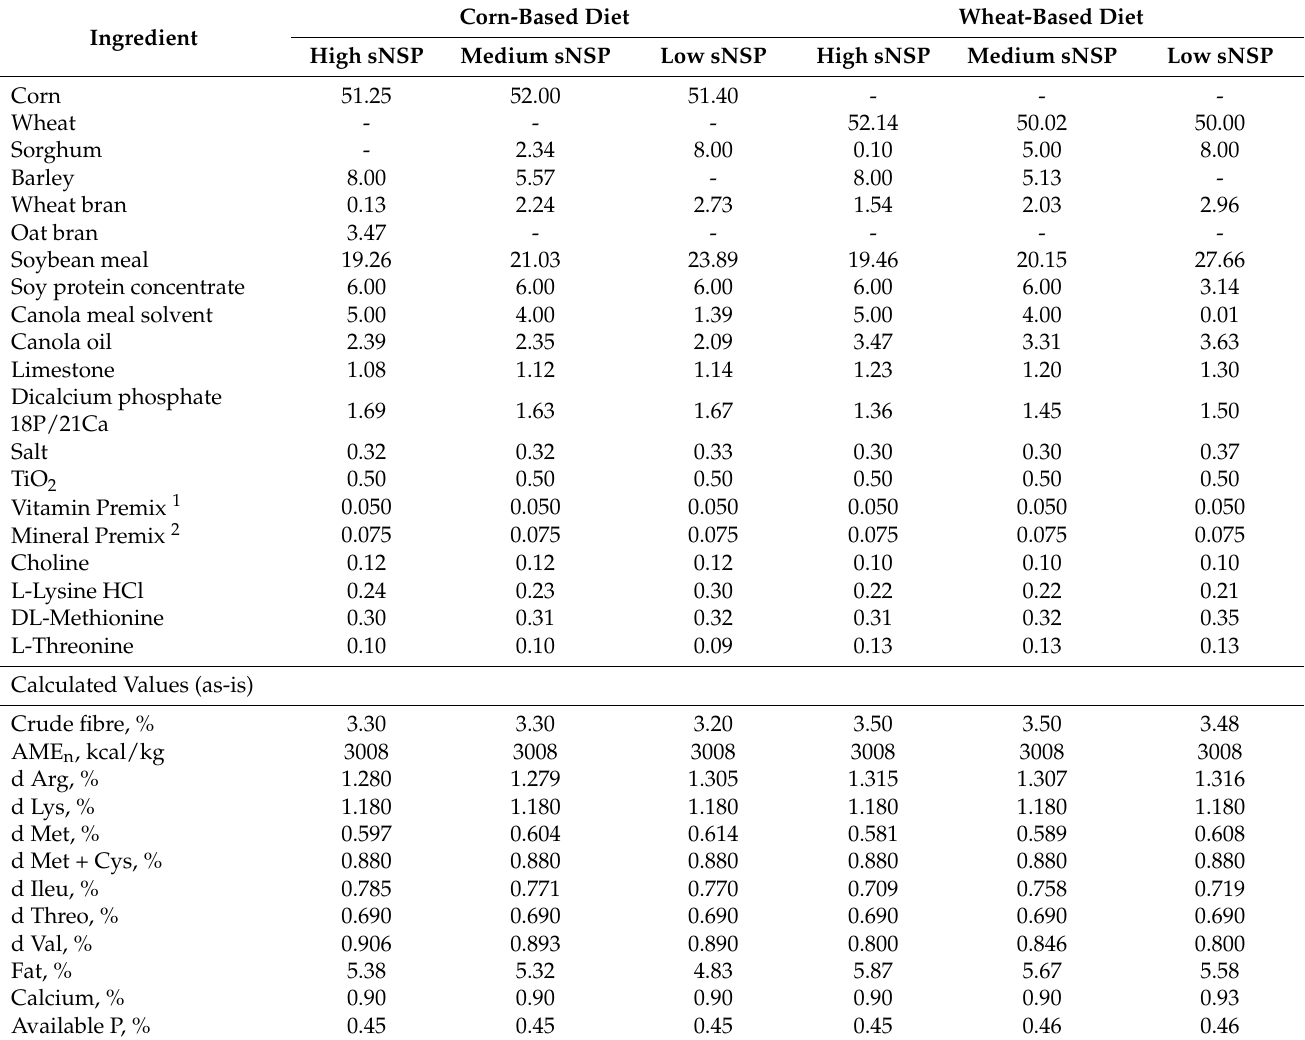
Table 2. Composition of starter diets (g/100 g, as fed